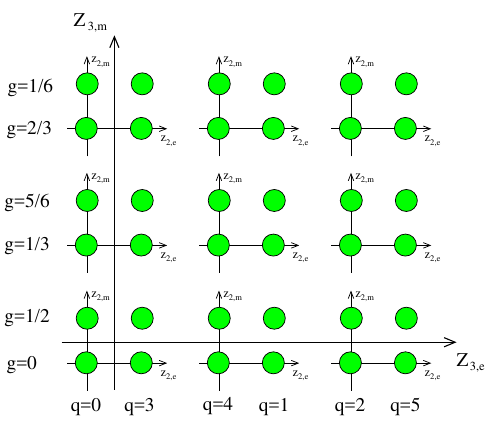
Figure 5 . (cid:0) = Z 6 . The Abelian lines are generated by ( q; g ) = (6 ; 0) and (0 ;